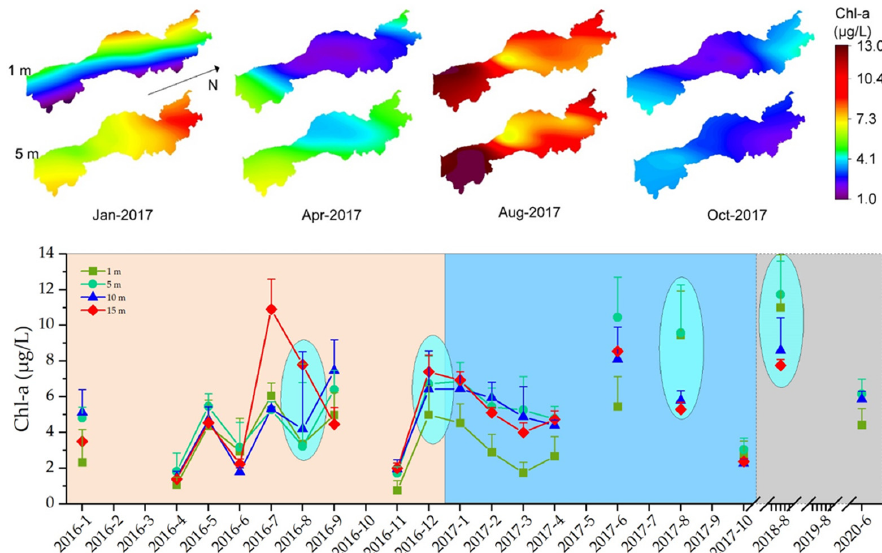
Figure 6. Spatiotemporal changes in Chl ‐ a.